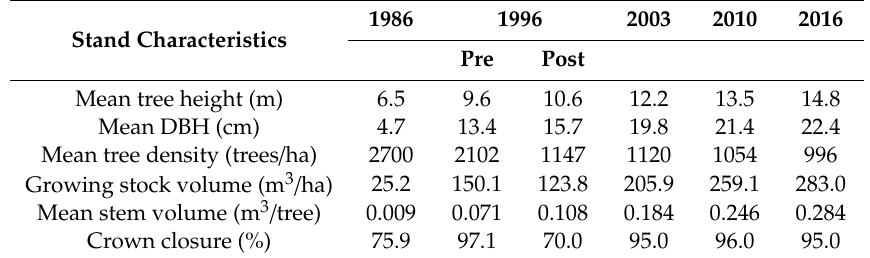
Table 2. Stand characteristics change of the GCP forest catchment before and after the forest thinning. Stand